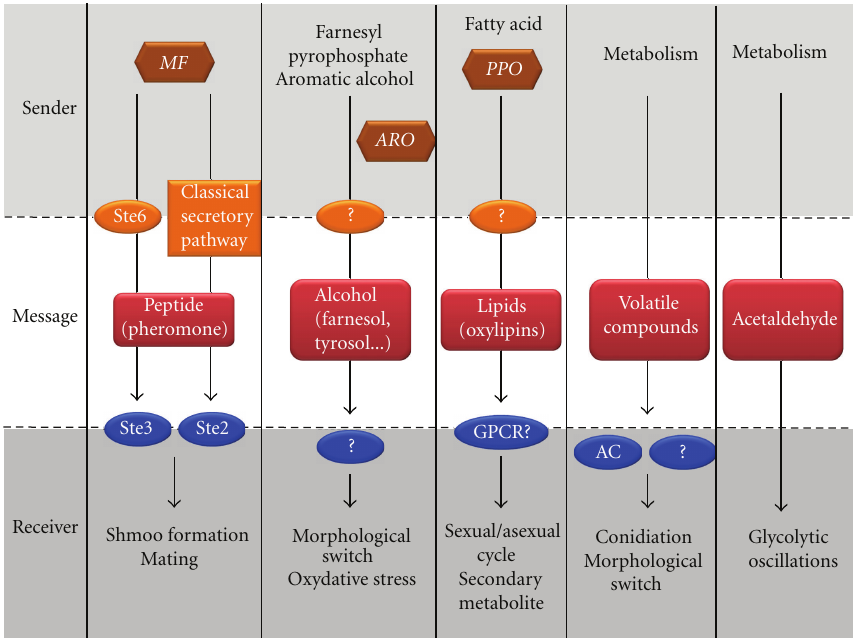
Figure 1: Schematic representation of fungal intra and interspecies communication. The “sender” is an organism from the fungal kingdom and the “receiver” can be from any kingdom. Genes involved in messenger synthesis are represented as brown hexagons. Proteins involved in secretion or receiving the message are in orange and